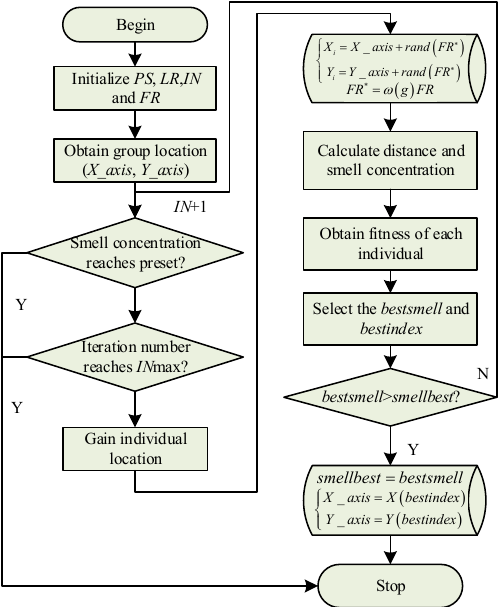
Figure 4. Flowchart of the improved fruit fly optimization algorithm.